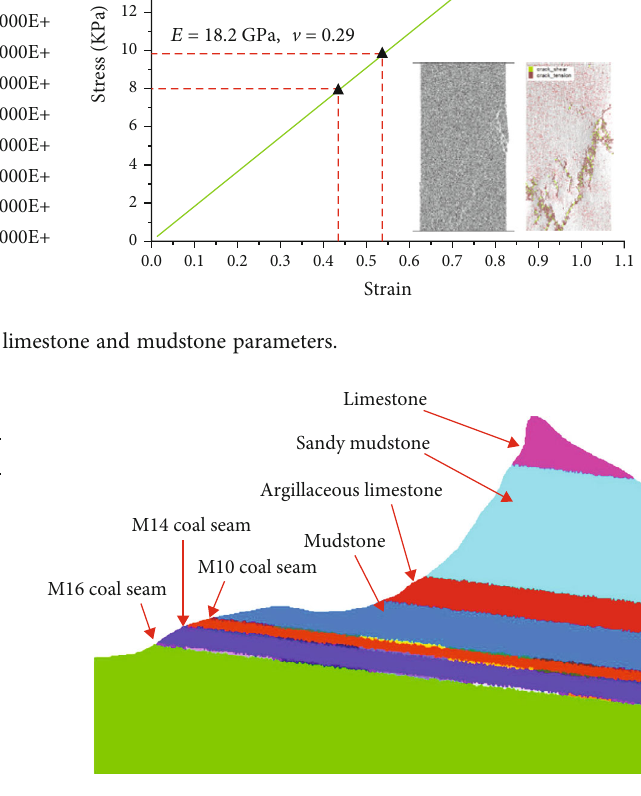
Figure 12: Schematic pro fi le of numerical